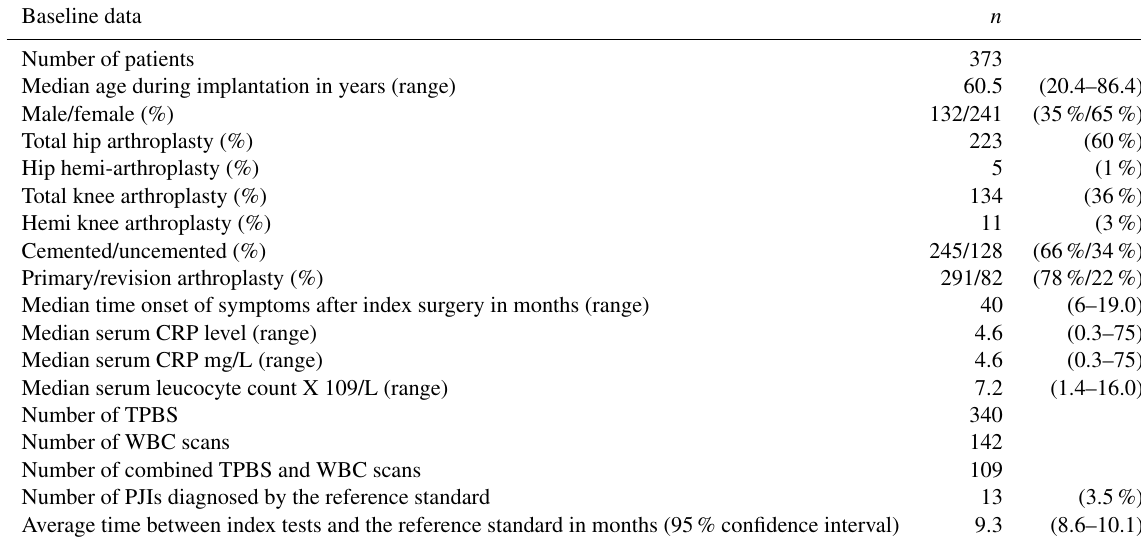
Table 1. Demographics.